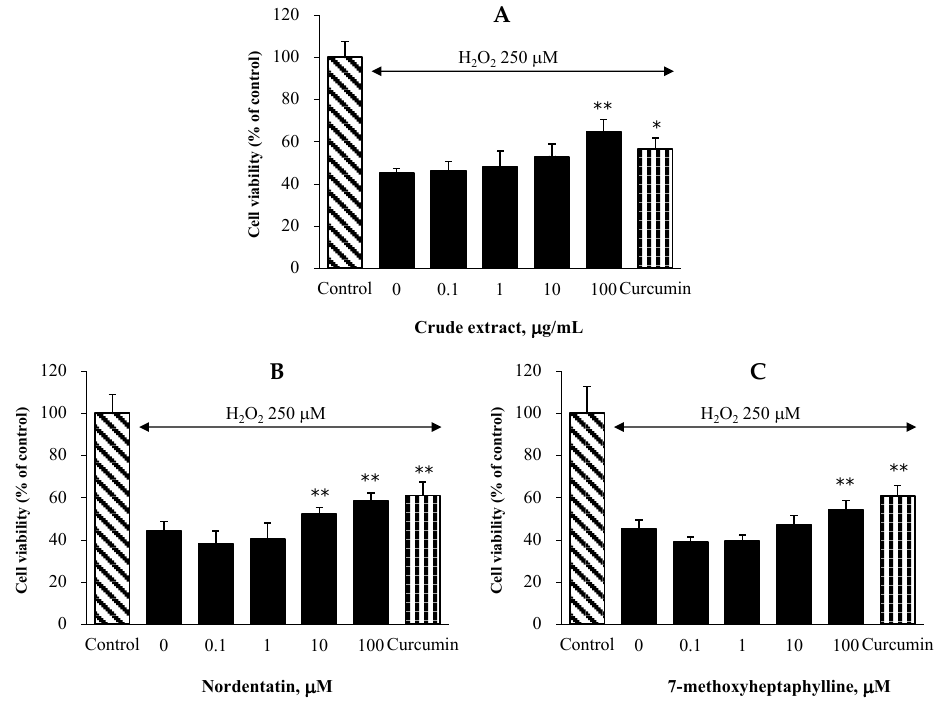
Figure 2. Effect of the CH extract at the concentrations of 0, 0.1, 1, 10, and 100 µ g/mL ( A ) and its constituents nordentatin ( B ) and 7-methoxyhepthaphylline ( C ) at the concentrations of 0, 0.1, 1, 10,